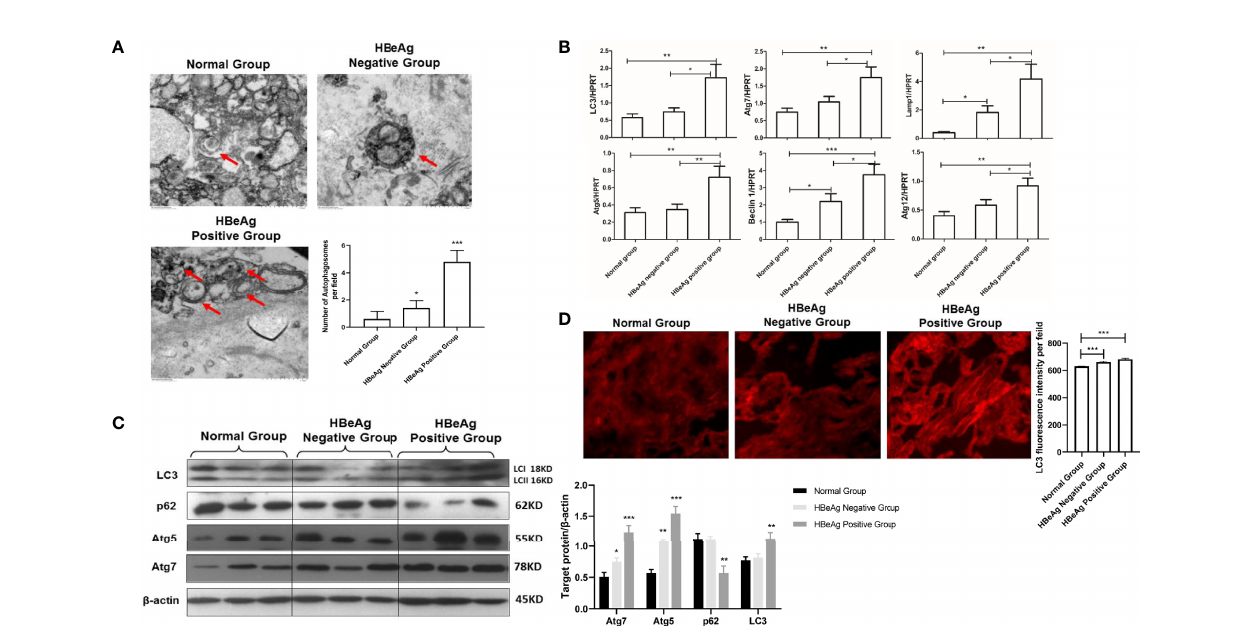
FIGURE 3 | Expression differences in autophagy markers in the placenta of HBeAg-positive or HBeAg-negative pregnant women. (***p<0.001, **p<0.01, *p<0.05). (A) The number of autophagosomes was detected by electron microscopy, the autophagosomes were indicated by red arrows and quanti fi ed by randomly selecting and screening 100 fi elds for two samples in the normal group, HBeAg-positive group, and HBeAg-negative group, respectively. The representative images from each group are shown. (B) mRNA expression of LC3, ATG7, ATG12, ATG5, Lamp1, Beclin-1 was measured by qPCR among the normal group (25 cases), HBeAg- positive group (27 cases), and HBeAg-negative group (30 cases). Data are shown as mean ± SD of at least three independent experiments. (C) Protein expression of LC3, p62, ATG7, ATG5 and b -actin was measured by western blot among the normal group (25 cases), HBeAg-positive group (27 cases), and HBeAg-negative group (30 cases). The results were repeated at least three times. A representative image from placental tissue of normal group, HBeAg-positive group, and HBeAg- negative group is shown. (D) The protein levels of LC3 were measured with immuno fl uorescent assays in placental tissue of normal group, HBeAg-positive group, and HBeAg-negative group (200×). The quantitative analysis of LC3 fl uorescence intensity per fi eld was examined by Image